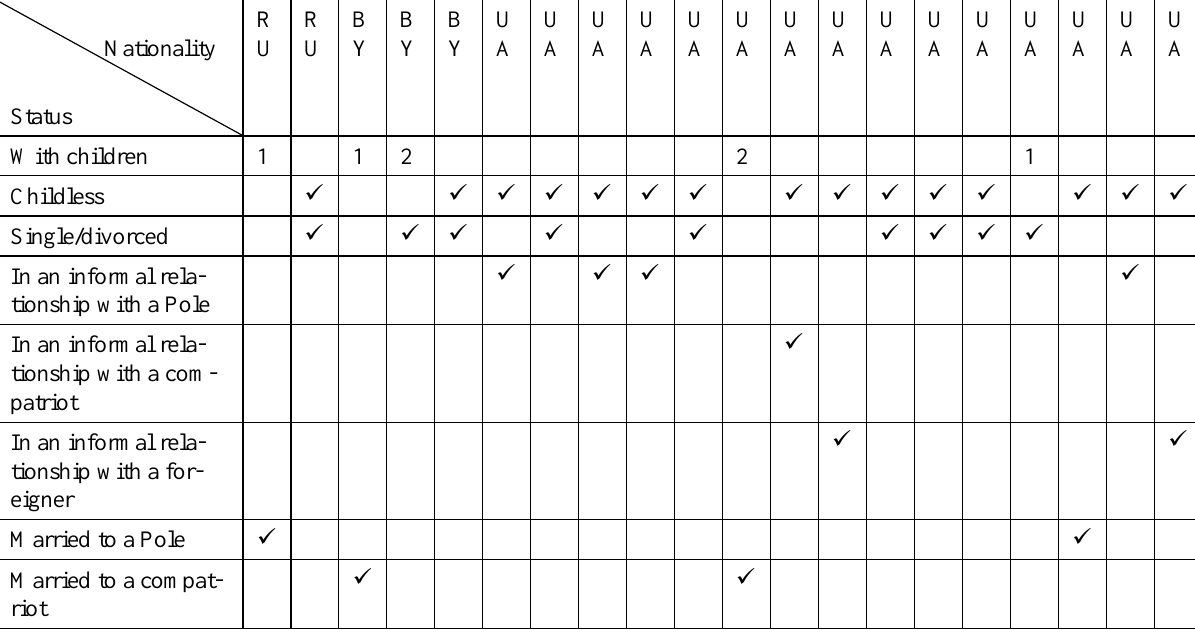
Table 3. Civil and family status of the